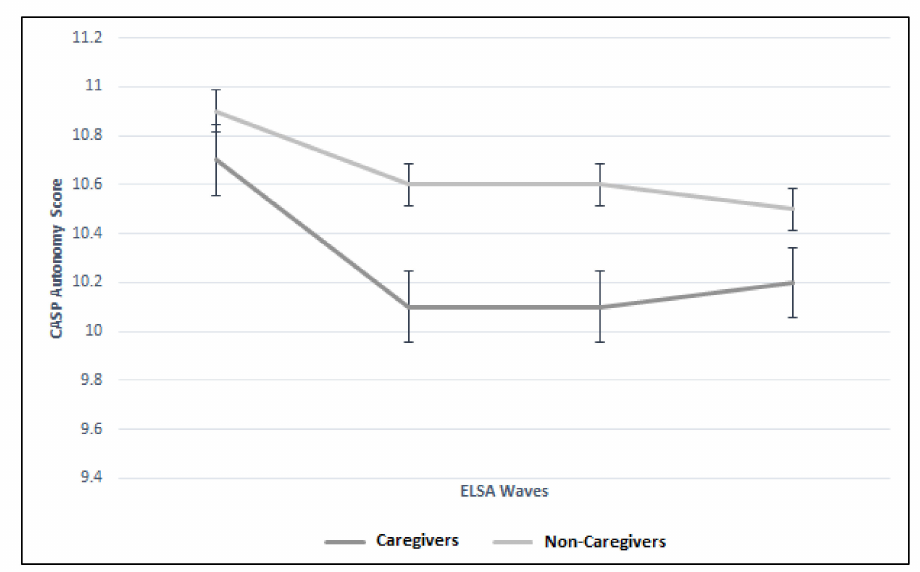
Figure 5. Trajectory of autonomy CASP score between caregiver and non-caregiver cohorts across four ELSA